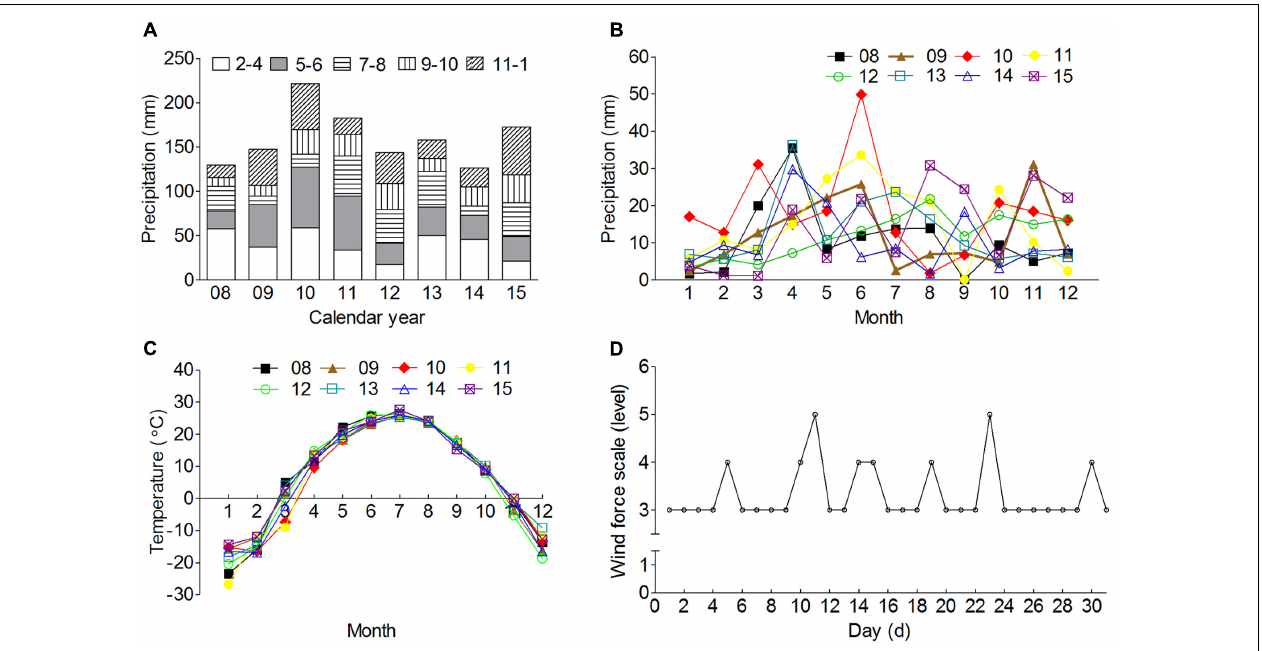
FIGURE 1 | The information of precipitation, average temperature and wind force of the natural habitat of S. ferganica. (A) Annual precipitation from 2008 to 2015. 2–4, 5–6, 7–8, 9–10, or 11–1: represents precipitation from February to April in spring, May to June in early summer, July to August in summer, September to October in autumn, November to January in winter, respectively. (B) Monthly precipitation of whole year from 2008 to 2015. (C) Monthly average temperature of whole year from 2008 to 2015. (D) Daily wind force in October 2015. 08, 09, 10, 11, 12, 13, 14, and 15: represent calendar years of 2008, 2009, 2010, 2011, 2012, 2013, 2014, and 2015, respectively. TABLE 1 | The physical and chemical properties of the natural habitat soil of S. ferganica. Depth (cm) Organic carbon Conductance (mg/g)